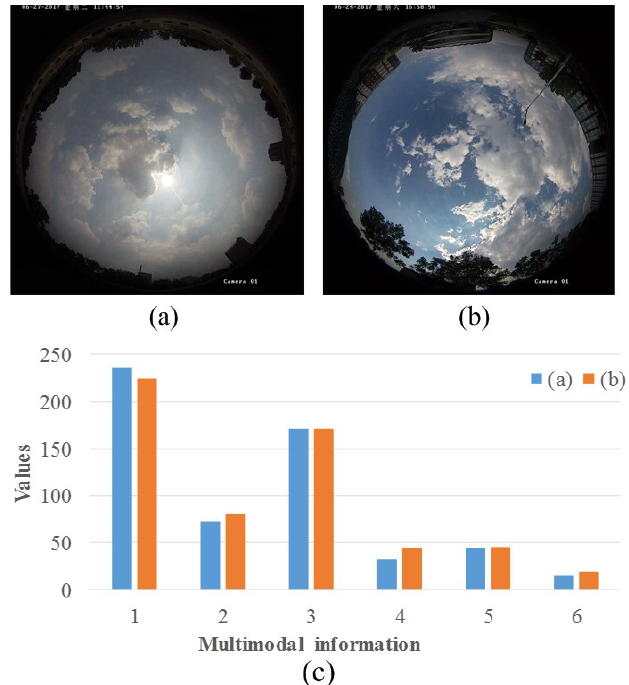
Figure 1. Illustration of ground-based cloud data with the same type (cumulus): ( a , b ) ground-based cloud images from cumulus; and ( c ) the corresponding multimodal information of ( a , b ). In ( c ), the Arabic numbers along the horizontal axis correspond to the multimodal information, i.e., temperature, humidity, pressure, wind speed, maximum wind speed and average wind speed. The vertical axis in ( c ) indicates the value of the multimodal information, which is normalized to the range of 0 to